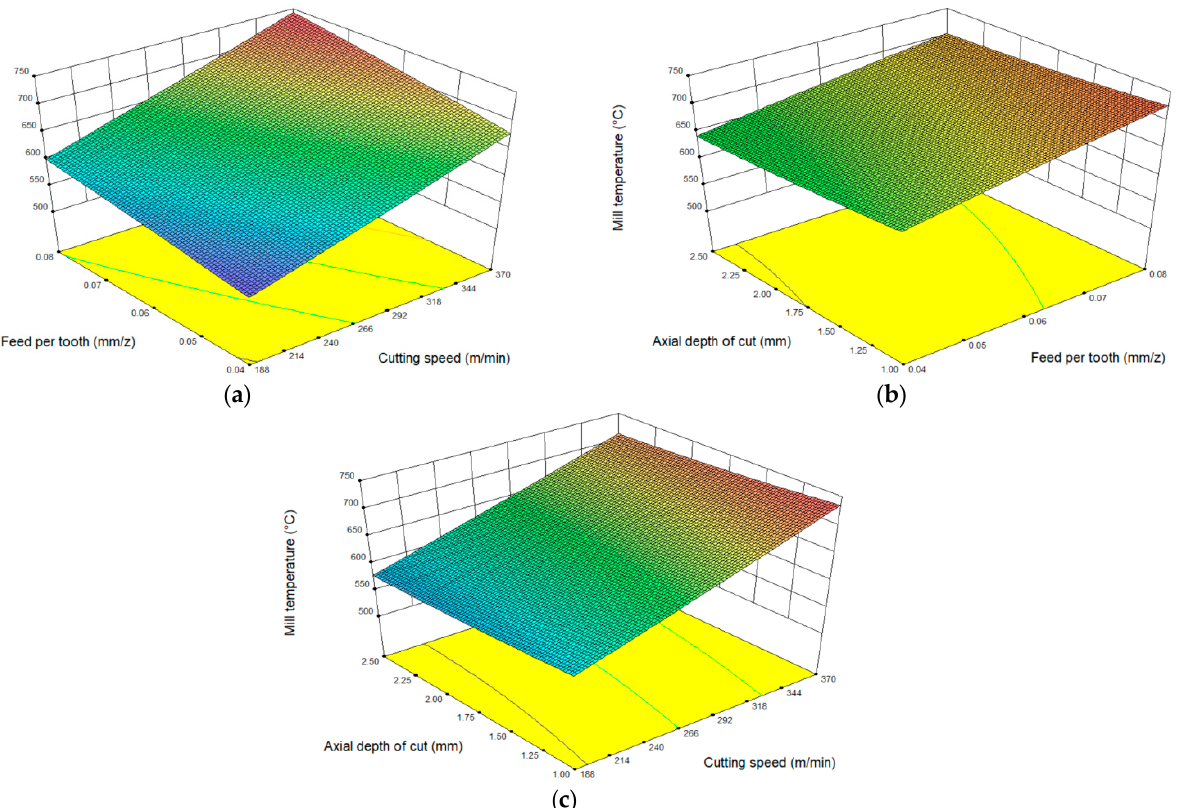
Figure 7. Response surface of interaction between different cutting parameters to milling temperature. ( a ) Influence of feed per tooth and cutting speed on milling temperature, ( b ) Influence of axial depth of cut and feed per tooth on milling temperature, ( c ) Influence of axial depth of cut and cutting speed on milling temperature.